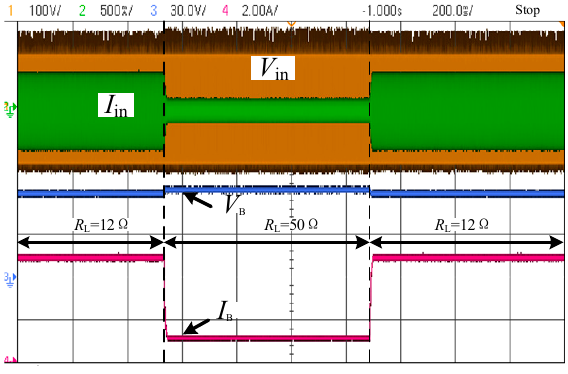
Figure 9. The transient waveforms of V in , I in , V B , I B when the load switches between 12 Ω and 50 Ω .